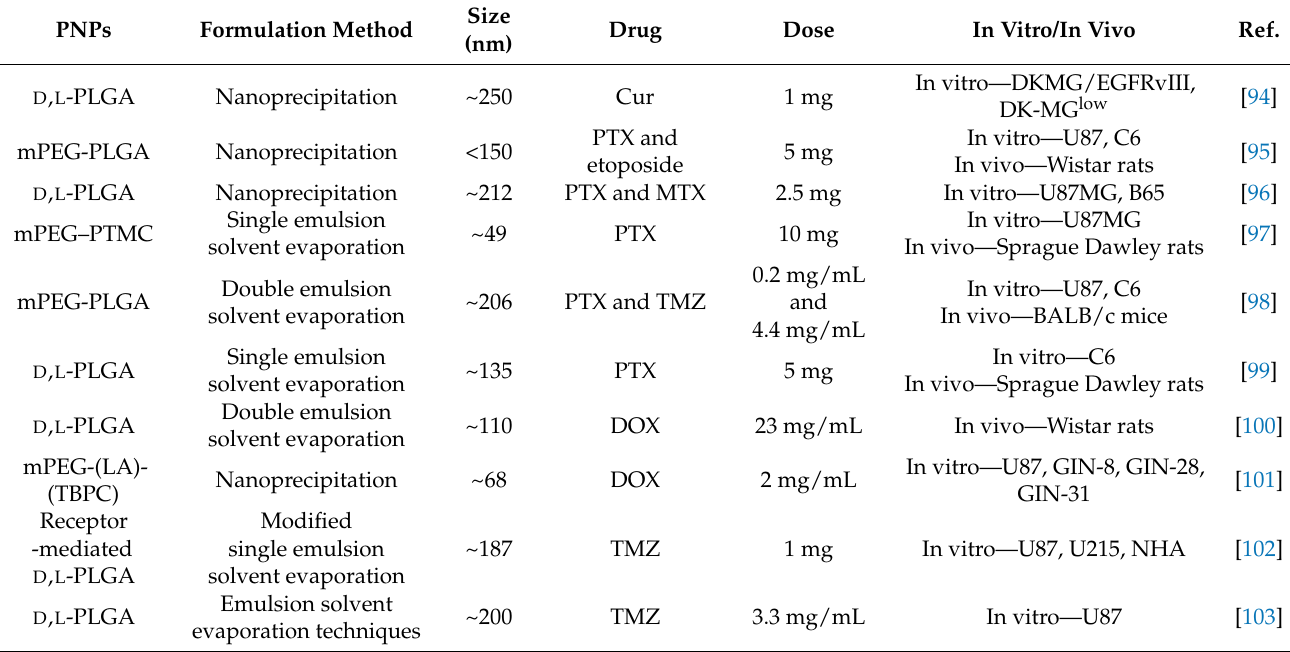
Table 6. Polymeric nanoparticles in glioblastoma multiforme treatment.